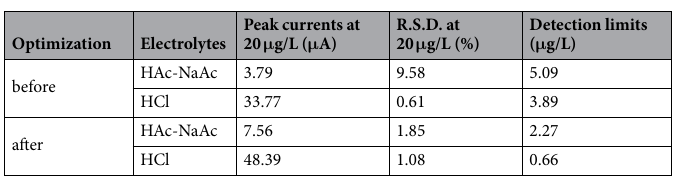
Table 2. Comparisons of peak currents, relative standard deviation (R.S.D.) and detection limits before and after parameters optimization in two